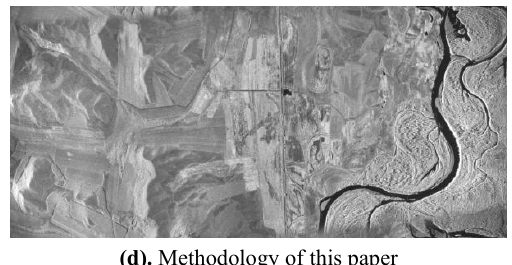
Figure 4. VV-polarized SAR images of the Genhe area